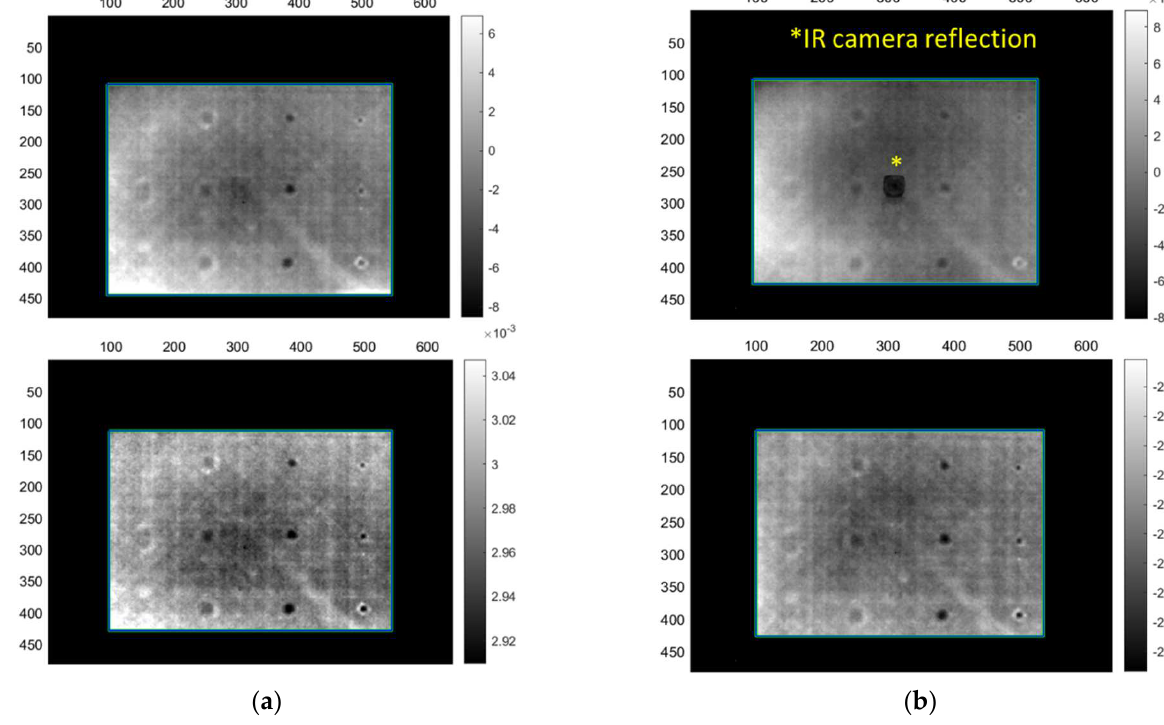
Figure 9. Step-heating thermography PCT ( top ) and FT phase ( bottom ) images from inspection of the CFRP monolithic sample. ( a ) Images from acquisition SHM5, ( b ) SHM6. Table 12. Step-heating results from the inspection of the monolithic CFRP sample. Detection Raw PCT FT Amp FT Phase Depth Limit (mm) SHM1 1